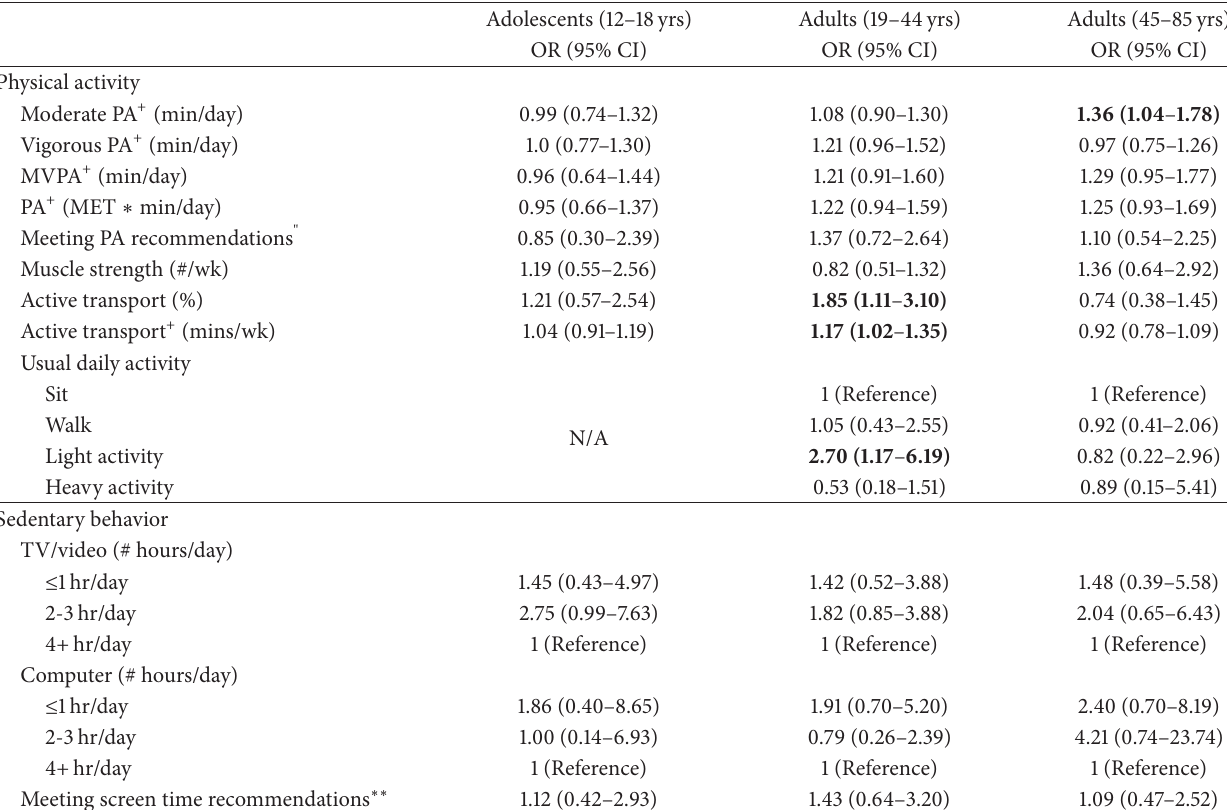
Table 3: Associations of MHO phenotypes ∗ with physical activity and screen time, among adolescents and adults ∧